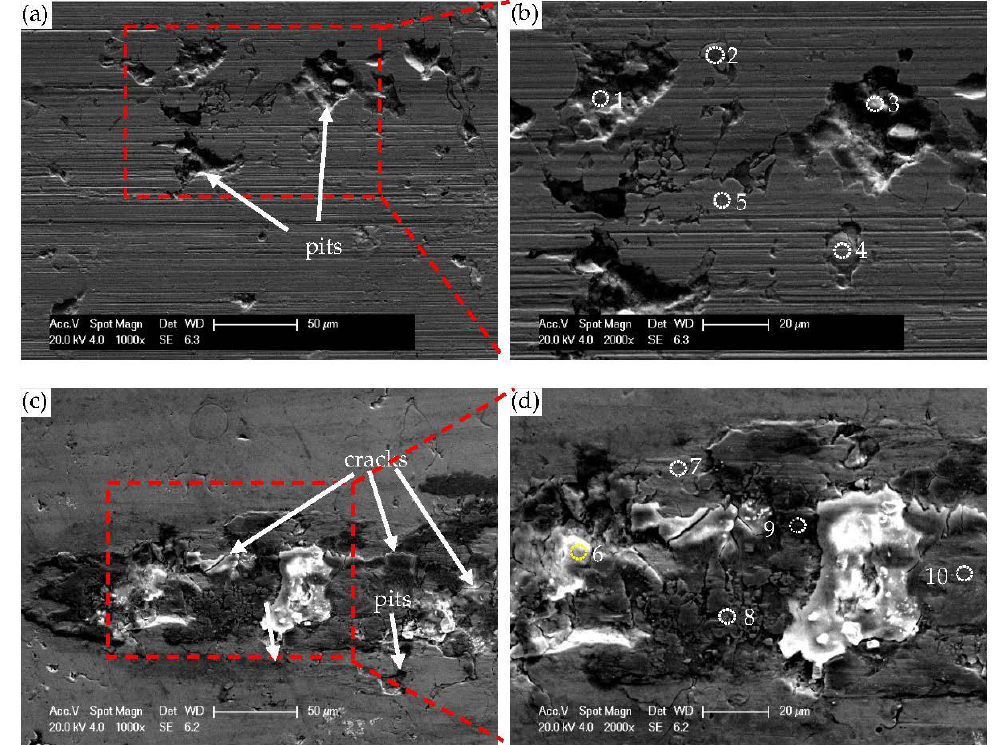
Figure 10. The wear morphology of Stellite 20 coating: ( a , b ) the wear morphology of HVAF spraying coating; ( c , d ) Wear morphology of HVOF sprayed coatings. The numbers in this figure correspond to the ‘Areas’ in Table 5, indicating that EDS analysis was performed at these locations. Table 5. EDS results of the corresponding region of Stellite 20 coating wear morphology (at%).